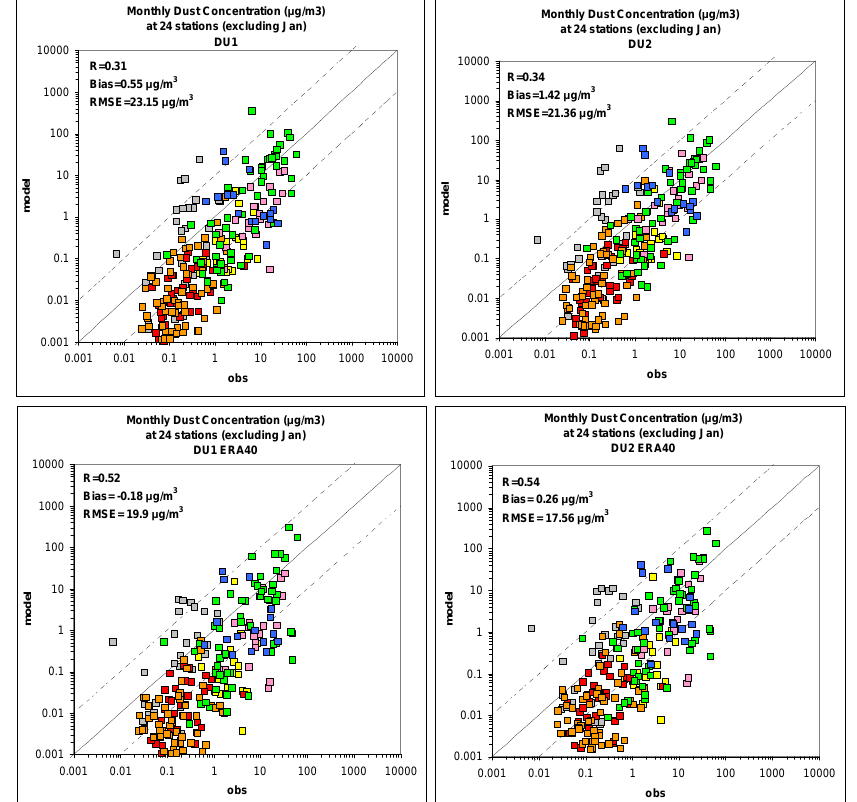
Fig. 7. Comparison of modelled monthly with measured multi-annual dust concentrations at 24 stations (January excluded). The colours correspond to the location of each station, as shown in Fig. 3a. E-Pacific = red, W-Pacific = orange, S-Africa = blue, Atlantic = green, Aus- tralia = yellow, Asia = pink, S-Ocean = grey. The dotted lines denote the 1 : 10 to 10 : 1